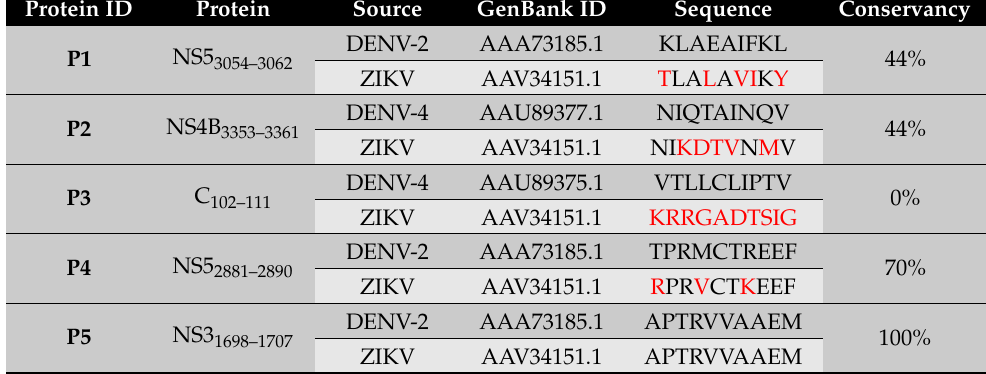
Table 4. Alignment of the encoded amino acid sequences of proteins encoded by DENV serotypes 2 and 4 with ZIKV strain MR766 revealed sequence conservation in the range of 44–100% for 4 of the 5 peptides as shown. HLA-B*07-restricted DENV-derived peptides (P4 and P5) were highly conserved compared to HLA-A*02-restricted peptides (P1, P2, and P3). Amino acids highlighted in red are sites of sequence divergence. Protein ID Protein Source GenBank ID